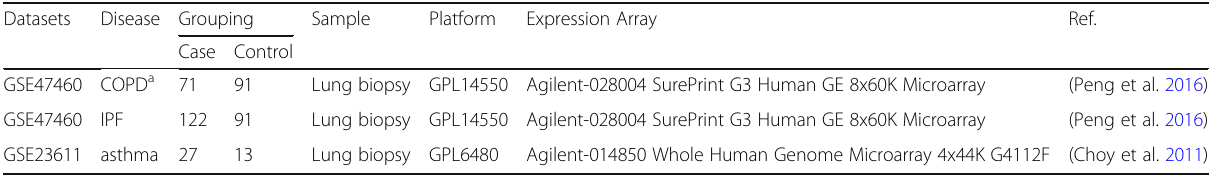
Table 1 Characteristics of Selected Microarray Data Series Datasets